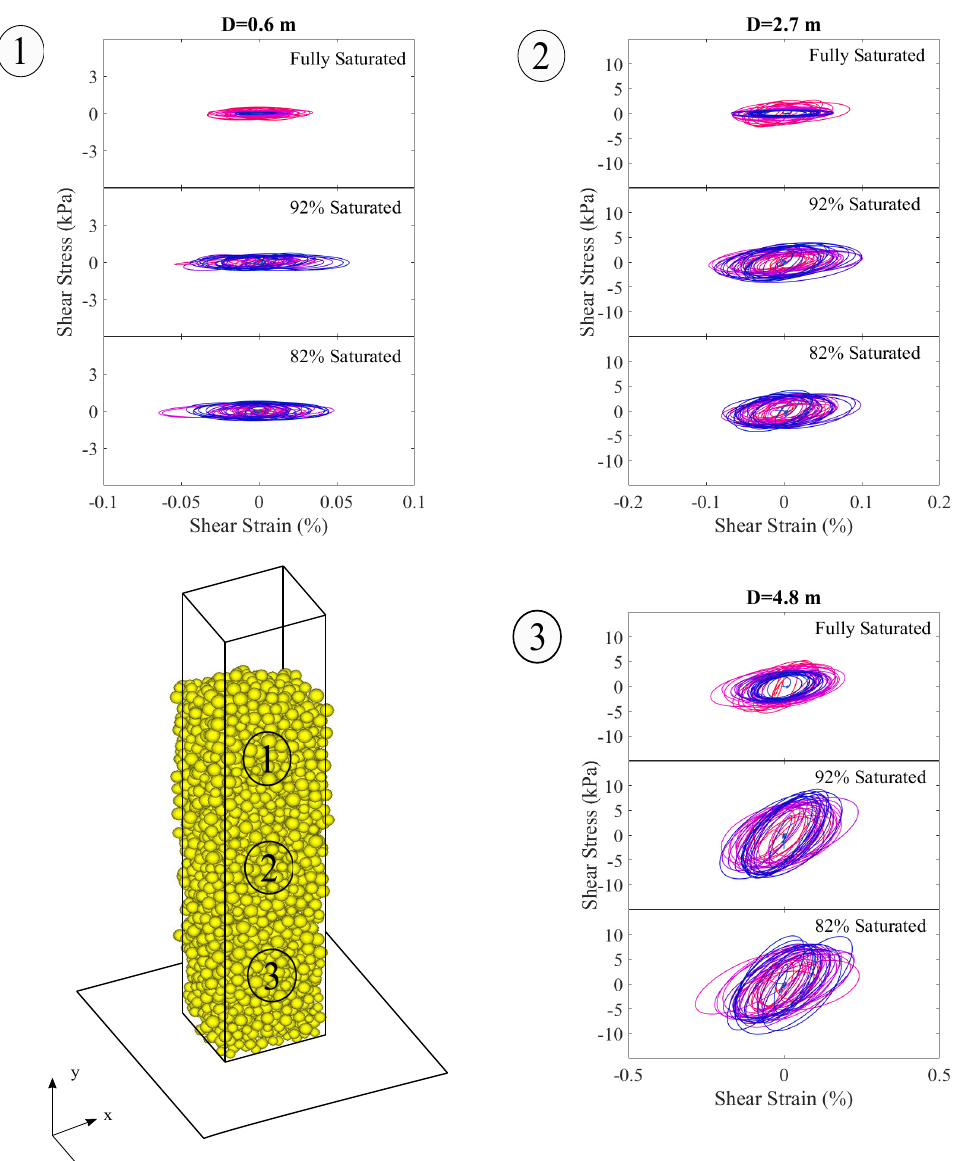
Figure 10. Shear stress–strain loops at selected depth locations for soil deposits with different degrees of